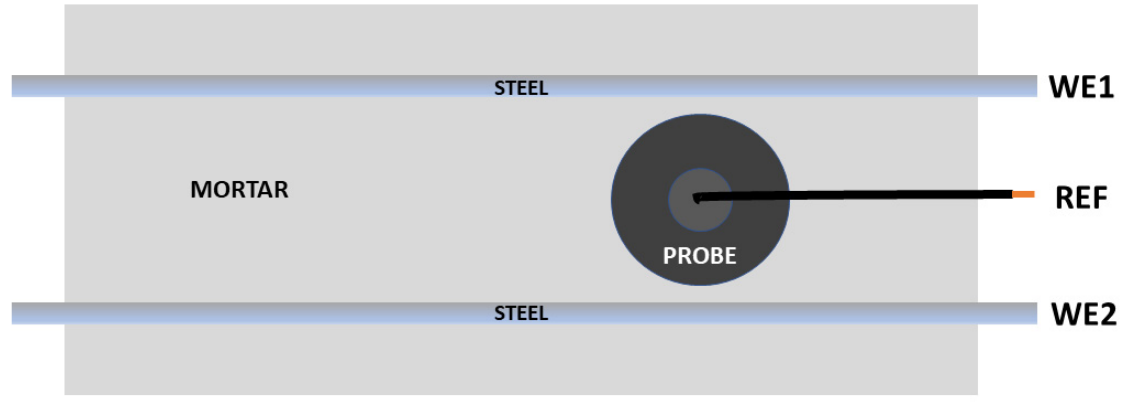
Figure 4. Schematic of bridge arrangement for ENM measurement.